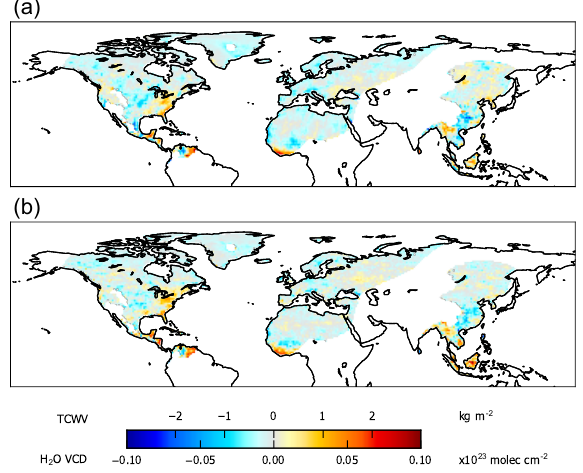
Figure 7. Mean difference of TCWV between GOME-2 and GOME after tape recorder failure during the overlap period Jan- uary 2007 to February 2010 calculated as the mean of monthly means (a) . Oceans and regions with poor GOME coverage are masked out. For comparison, (b) displays the indirect difference between GOME-2 and GOME, as derived from the difference be- tween GOME-2 and SCIAMACHY (Fig. 3c) minus the difference between GOME and SCIAMACHY (Fig. 5) for the same spatial selection.